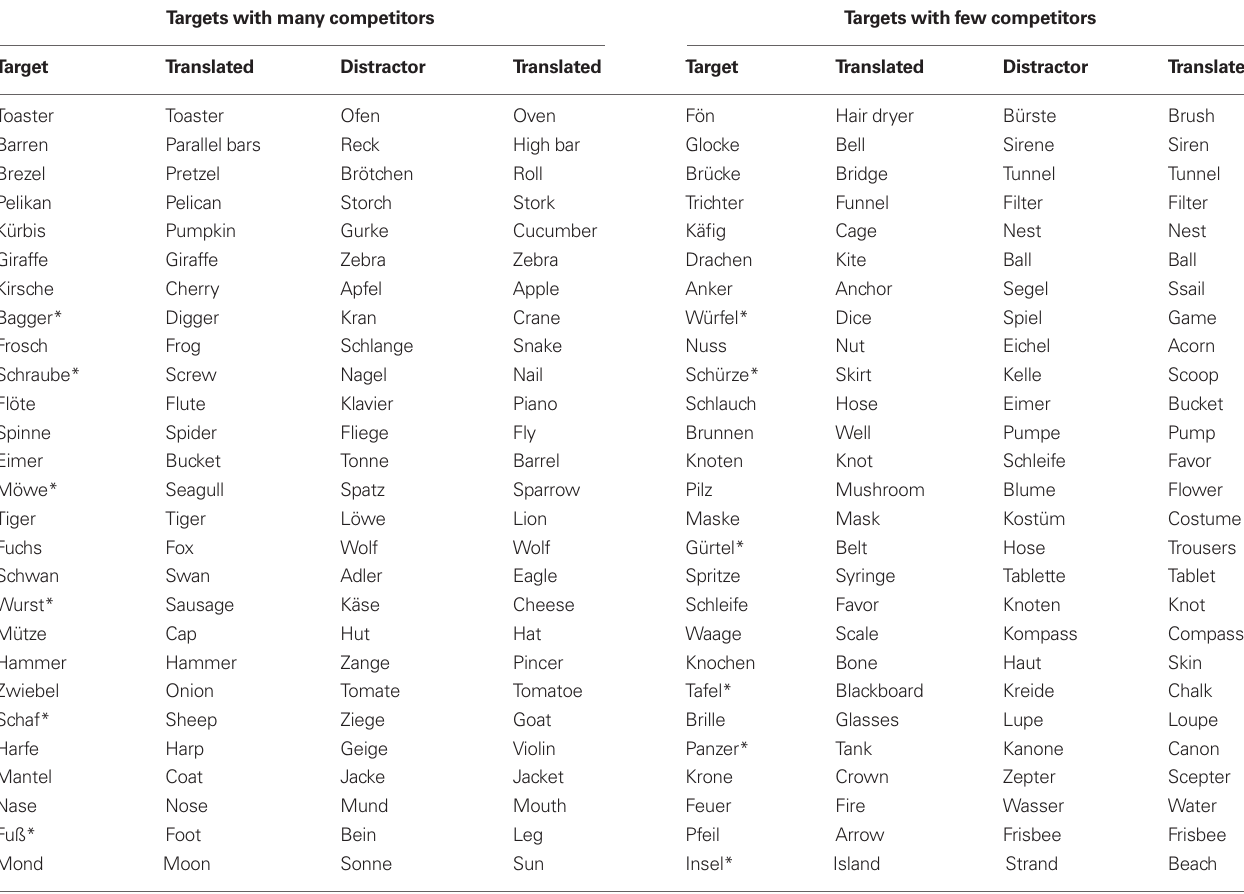
*Excluded for re-analysis of Experiment 3 (see text for